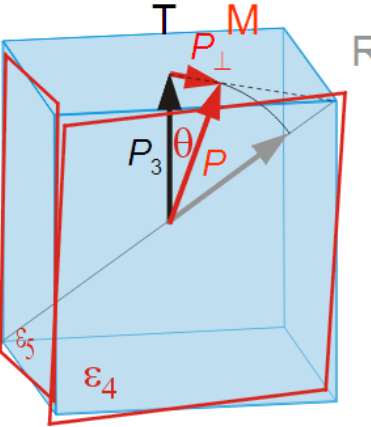
Figure 8. Rotation of the polarization and coupled shear deformation at the T → M